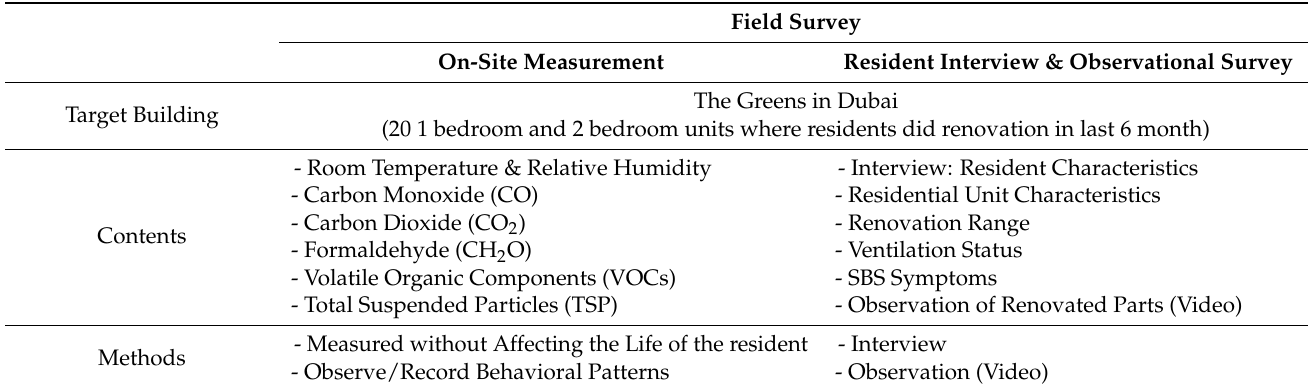
Table 4. Overview of field